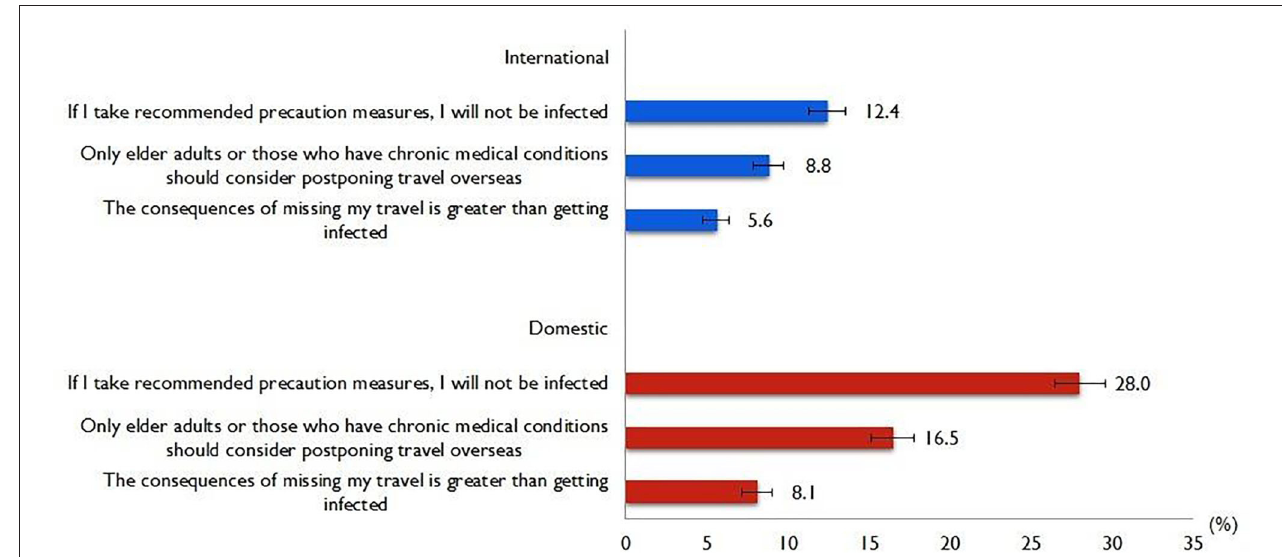
FIGURE 1 | Risk perceptions of international and domestic